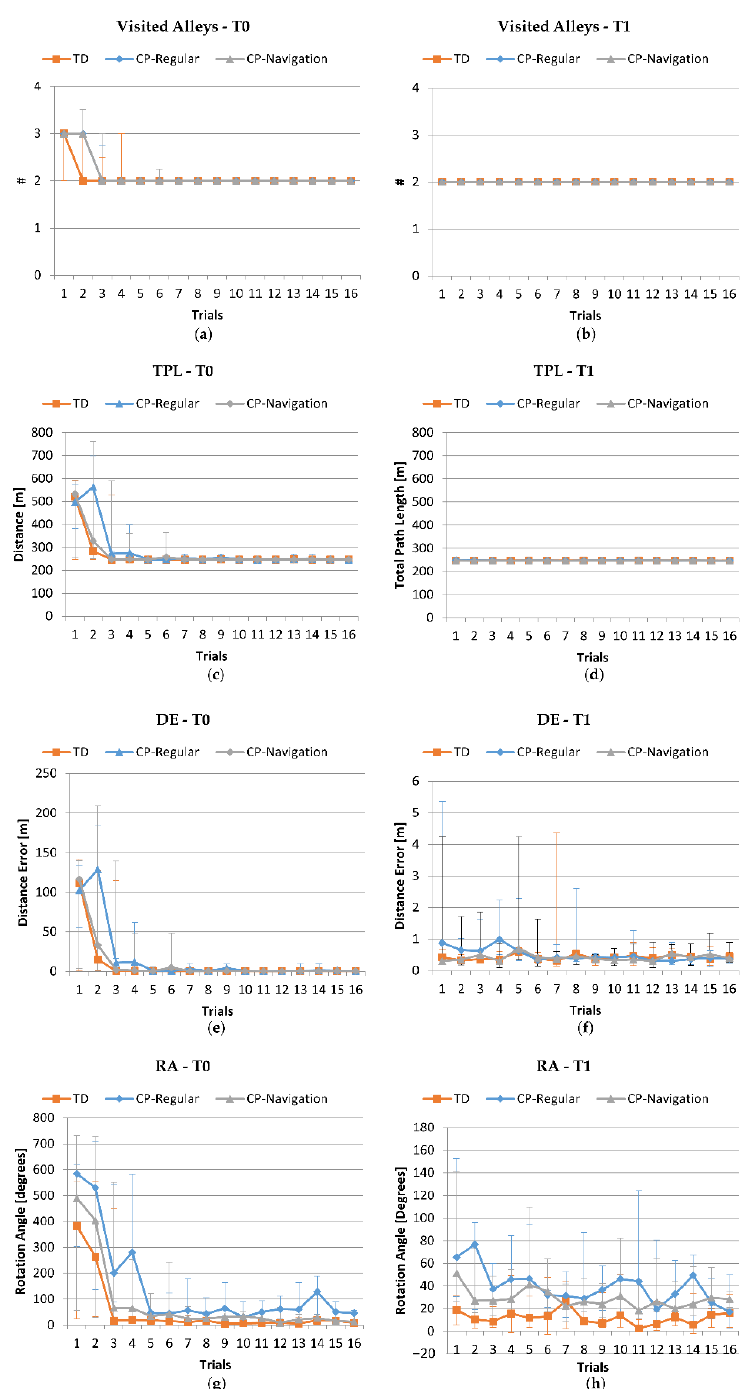
Figure 5. Navigation skills and modifications during the training in the Free Navigational Task evaluated at T0 (left side) and T1 (right side). Learning curves of TD subjects (orange) and participants with CP (CP-Regular: blue, CP-Navigation: grey) were obtained during 16 training sessions. ( a , b ) Number of visited alleys (the correct number is 2), at T0 and T1, respectively (#: number of visited alleys); ( c , d ) total path length (the minimum is 246 m), at T0 and T1, respectively; ( e , f ) distance error (%), at T0 and T1, respectively; ( g , h ) rotation angle, at T0 and T1, respectively. Median values and interquartile ranges are reported.